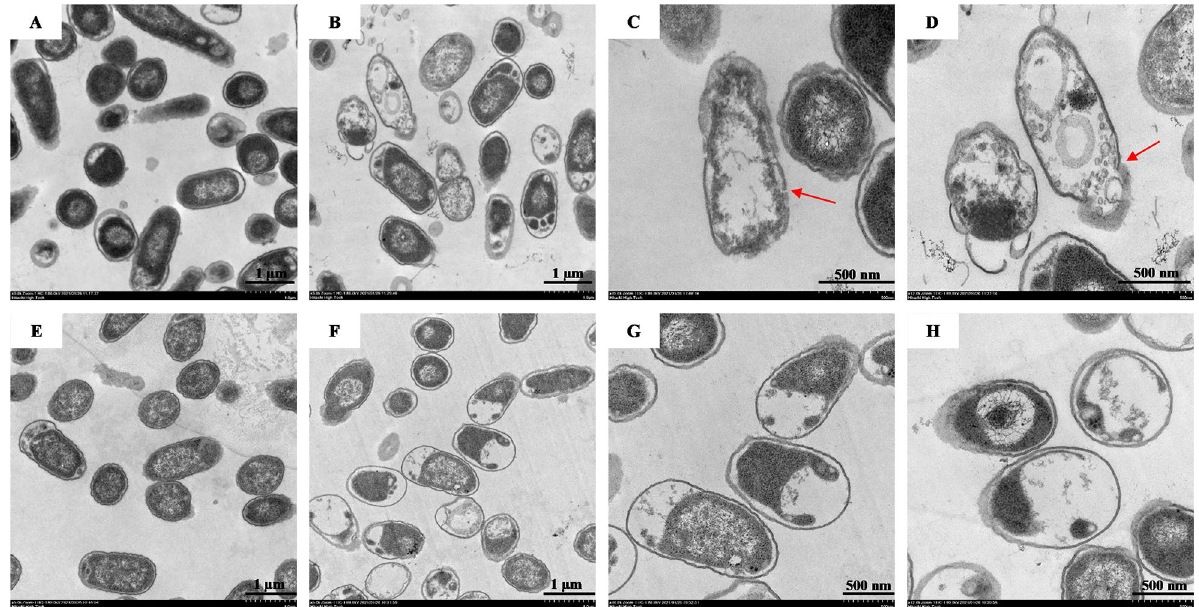
Figure 8. Transmission electron micrographs of S . Typhimurium ATCC 13311 exposed to 0.5 × MIC of A11. Control cells without A11 treatment, as a bacterial cell is obtained in 0.2 M PBS buffer for 4 and 12 h ( A and E , respectively). Bacteria treated with A11 for 4 h ( B – D ); and bacteria treated with A11 for 12 h ( F – H ). Red arrow indicates detectable pore and leakage of intracellular